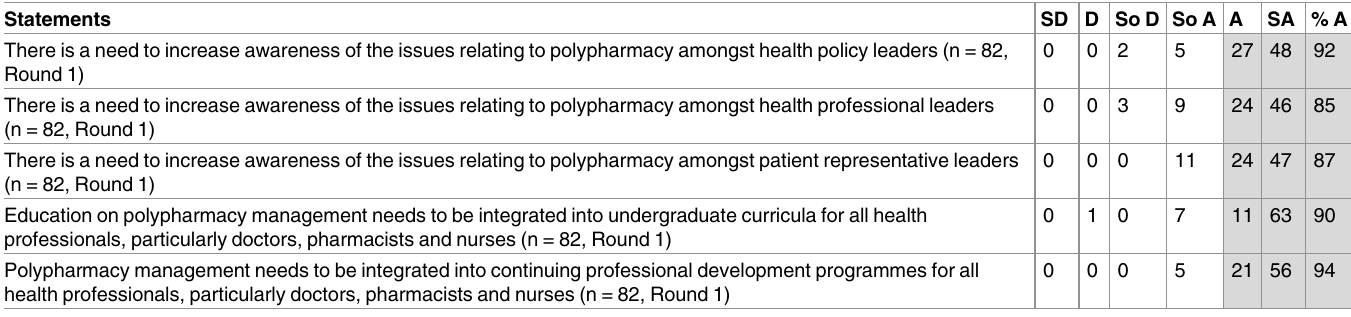
Table 7. Number of responses and % agreement(strongly agree/agree) to statements relating to awareness raising.